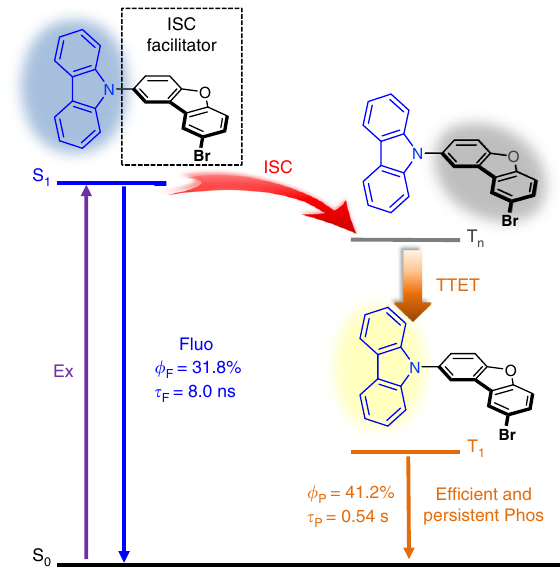
Fig. 1 Strategy to achieve ef fi cient OPRTP by intramolecular TTET process. Representation of the excited-state decay pathways in bromodibenzofuran- substituted carbazole, lifetime, and ef fi ciency in the crystalline